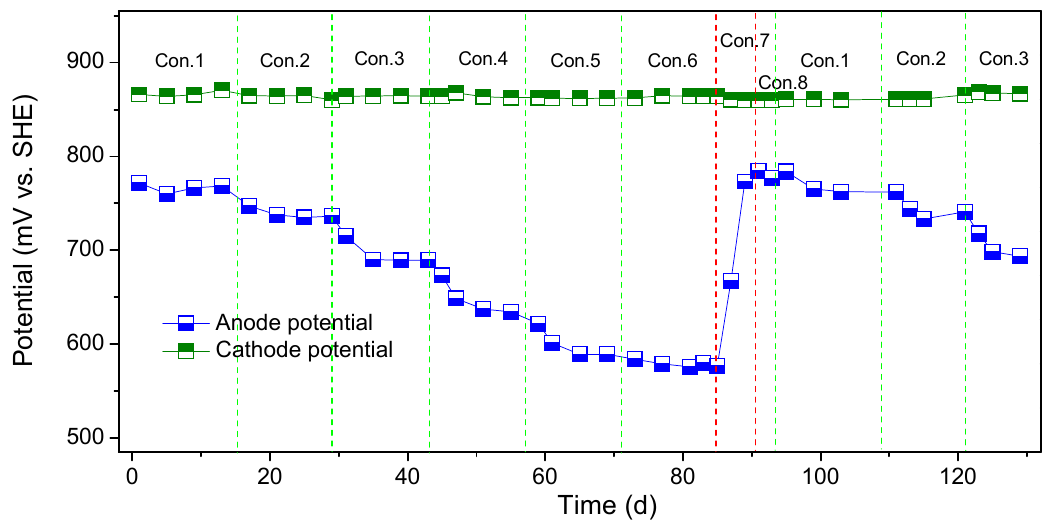
Figure 4. Variation in electrode potentials in the anode anammox MFC.